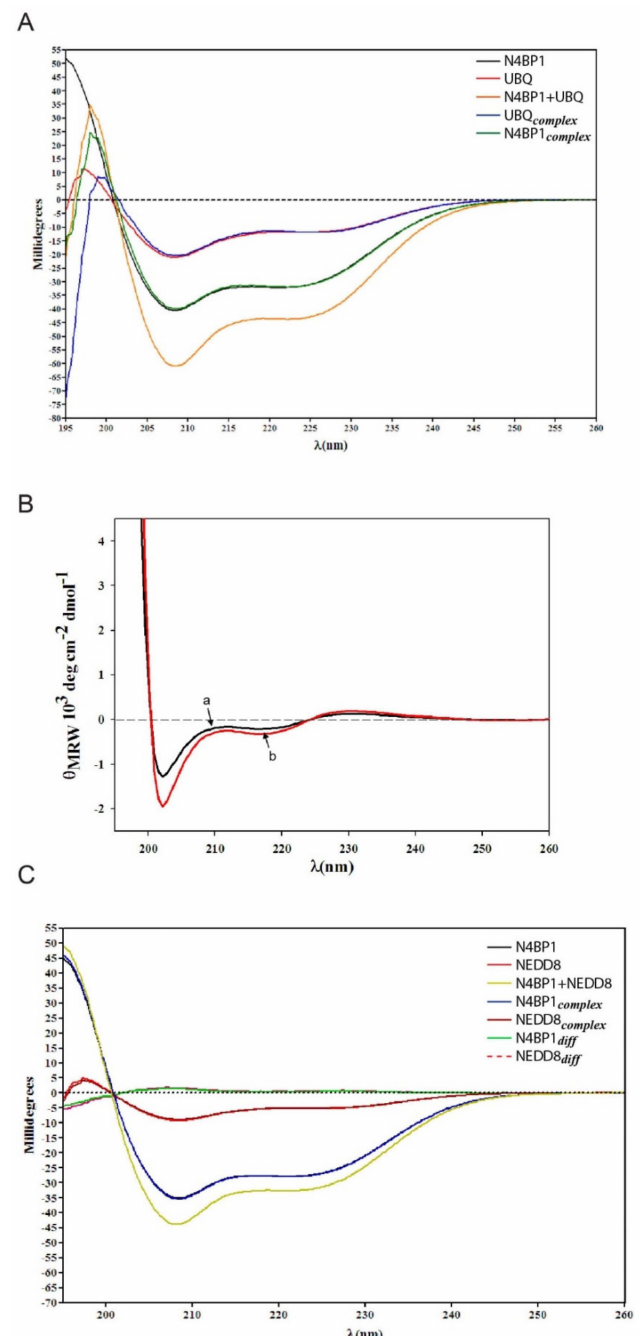
Figure 4. Conformational studies of N4BP1 in complex with either ubiquitin or NEDD8, performed by circular dichroism (CD). ( A ) CD spectra of N4BP1 and ubiquitin alone expressed as rotatory power are shown in black and red traces, respectively. The orange trace reports the CD spectrum of the 1:1 molar mix of N4BP1 and ubiquitin at the concentration of 30 µ M. The green trace (N4BP1 complex ) reports the CD spectrum of N4BP1 in the complex obtained after subtracting point-by-point from the CD of the complex (orange) and the CD spectrum of ubiquitin alone (red). Similarly, the blue trace reports the CD spectrum of ubiquitin in the complex obtained after subtraction of the CD spectrum of N4BP1 alone (black). ( B ) The di ff erences shown in ( A ) are amplified and here reported as mean residue